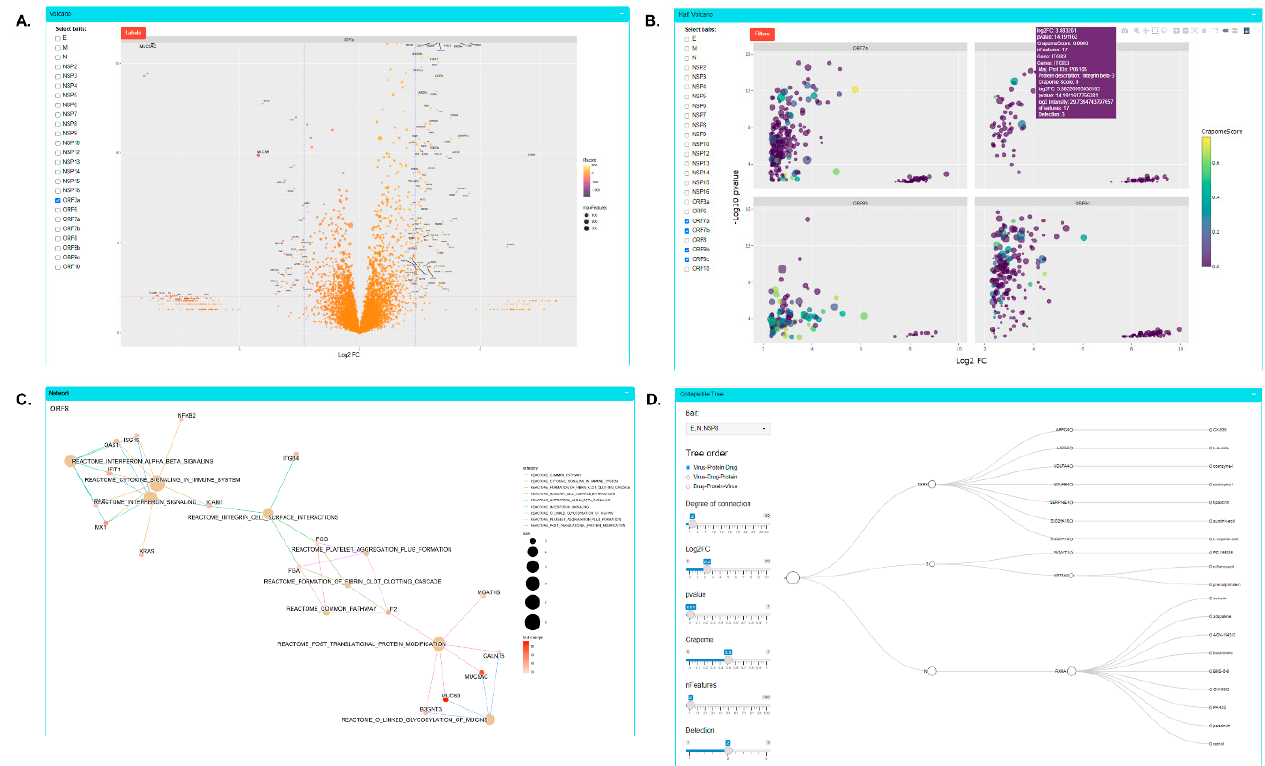
Figure 2. Examples of COVID-19 Proteomics website functionality. ( A ) Volcano plot analysis of changes in global protein abundance. ( B ) Half volcano plots showing enriched PPI candidates following BioID method. ( C ) Functional enrichment analysis of PPI candidates. ( D ) Protein–drug tree for viral proteins, PPI candidates, and known drug interactors.